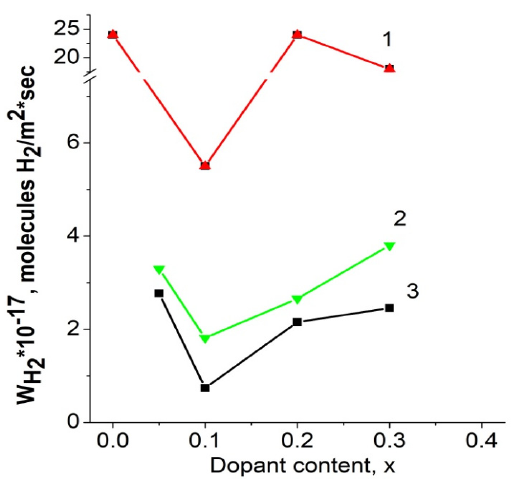
Figure 3. Specific rate of H 2 production in partial oxidation of methane for Pt/La x (Ce 0.5 Zr 0.5 ) 1-x O 2-y (1), Pt/Pr x (Ce 0.5 Zr 0.5 ) 1-x O 2-y (2) and Pt/Gd x (Ce 0.5 Zr 0.5 ) 1-x O 2-y (3) catalysts. Feed 1% CH 4 + 0.5% O 2 in He, 770 °C, contact time 5 ms.